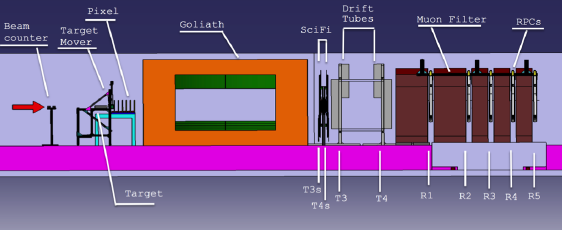
Figure 8. Setup of the charm measurement experiment built in